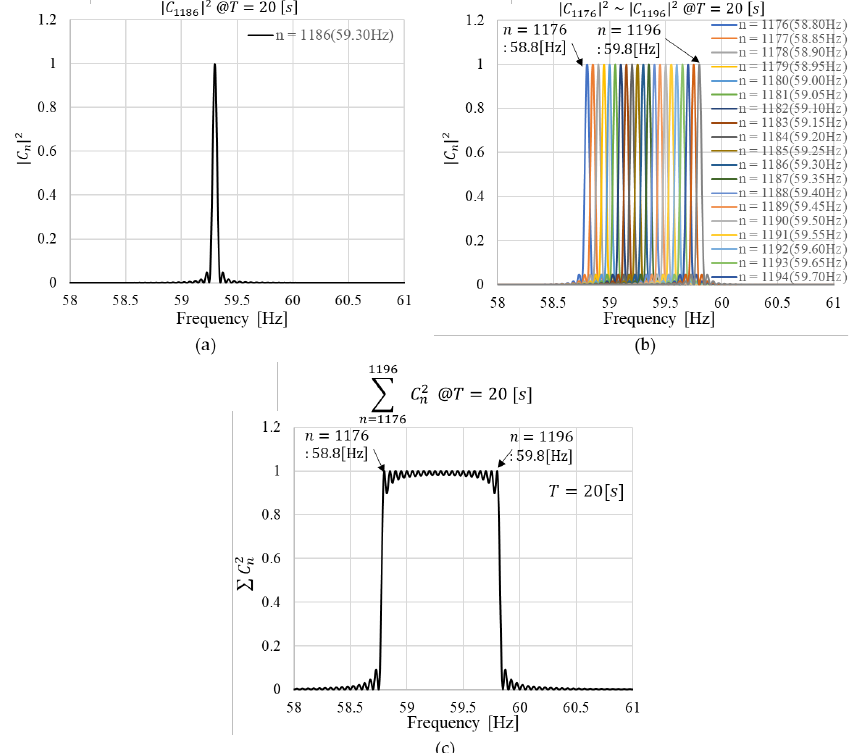
(cid:12) (cid:12) (cid:12) 2 , ( b ) (cid:12) 2 (cid:12) C 1186 (cid:12) C 1176